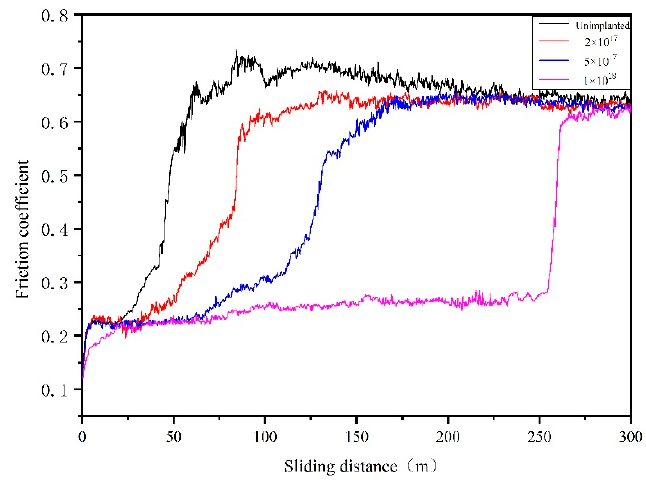
Figure 6. Variation curve of friction coefficient of different samples.